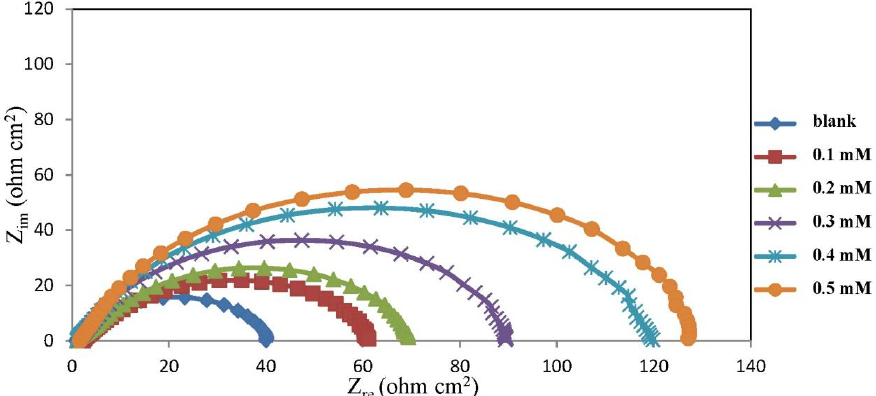
Figure 3. Nyquist plot for mild steel in 1.0 M HCl at 30 °C with different concentrations of chlorocurcumin.